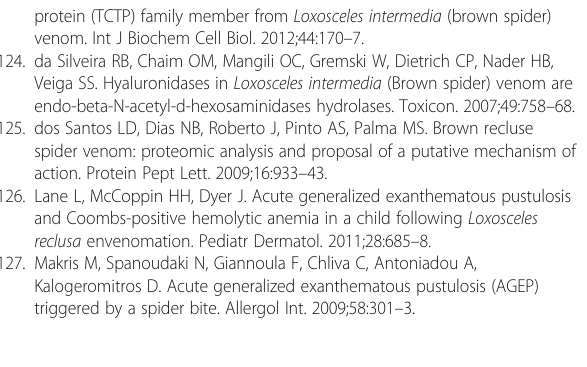
protein (TCTP) family member from Loxosceles intermedia (brown spider) venom. Int J Biochem Cell Biol. 2012;44:170 – 7. 124. da Silveira RB, Chaim OM, Mangili OC, Gremski W, Dietrich CP, Nader HB, Veiga SS. Hyaluronidases in Loxosceles intermedia (Brown spider) venom are endo-beta-N-acetyl-d-hexosaminidases hydrolases. Toxicon. 2007;49:758 – 68. 125. dos Santos LD, Dias NB, Roberto J, Pinto AS, Palma MS. Brown recluse spider venom: proteomic analysis and proposal of a putative mechanism of action. Protein Pept Lett. 2009;16:933 – 43. 126. Lane L, McCoppin HH, Dyer J. Acute generalized exanthematous pustulosis and Coombs-positive hemolytic anemia in a child following Loxosceles reclusa envenomation. Pediatr Dermatol. 2011;28:685 – 8. 127. Makris M, Spanoudaki N, Giannoula F, Chliva C, Antoniadou